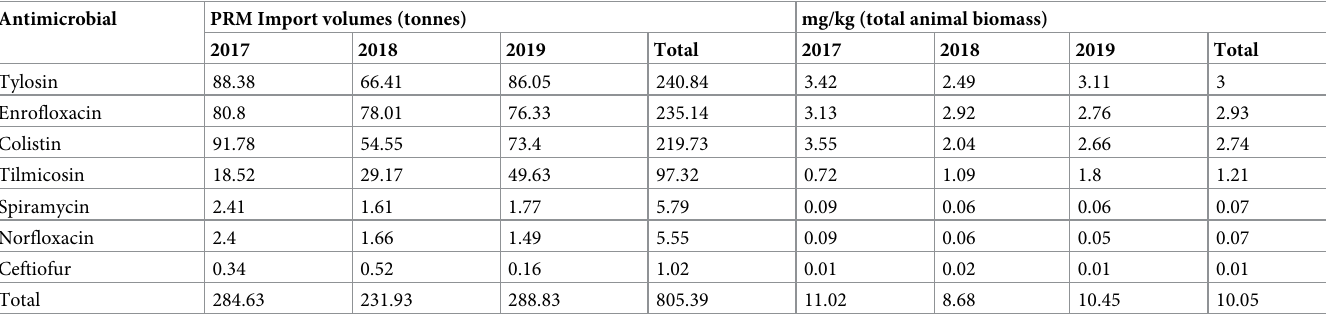
Table 2. Import volumes of WHO critically important antimicrobials with highest priority (CIA-HtP) for the years 2017–19. Antimicrobial PRM Import volumes (tonnes)